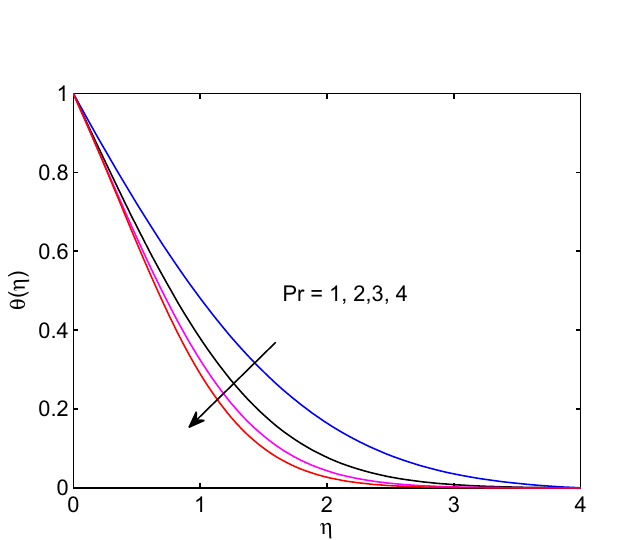
Figure 16. Wedge angle parameter effects on velocity profiles.